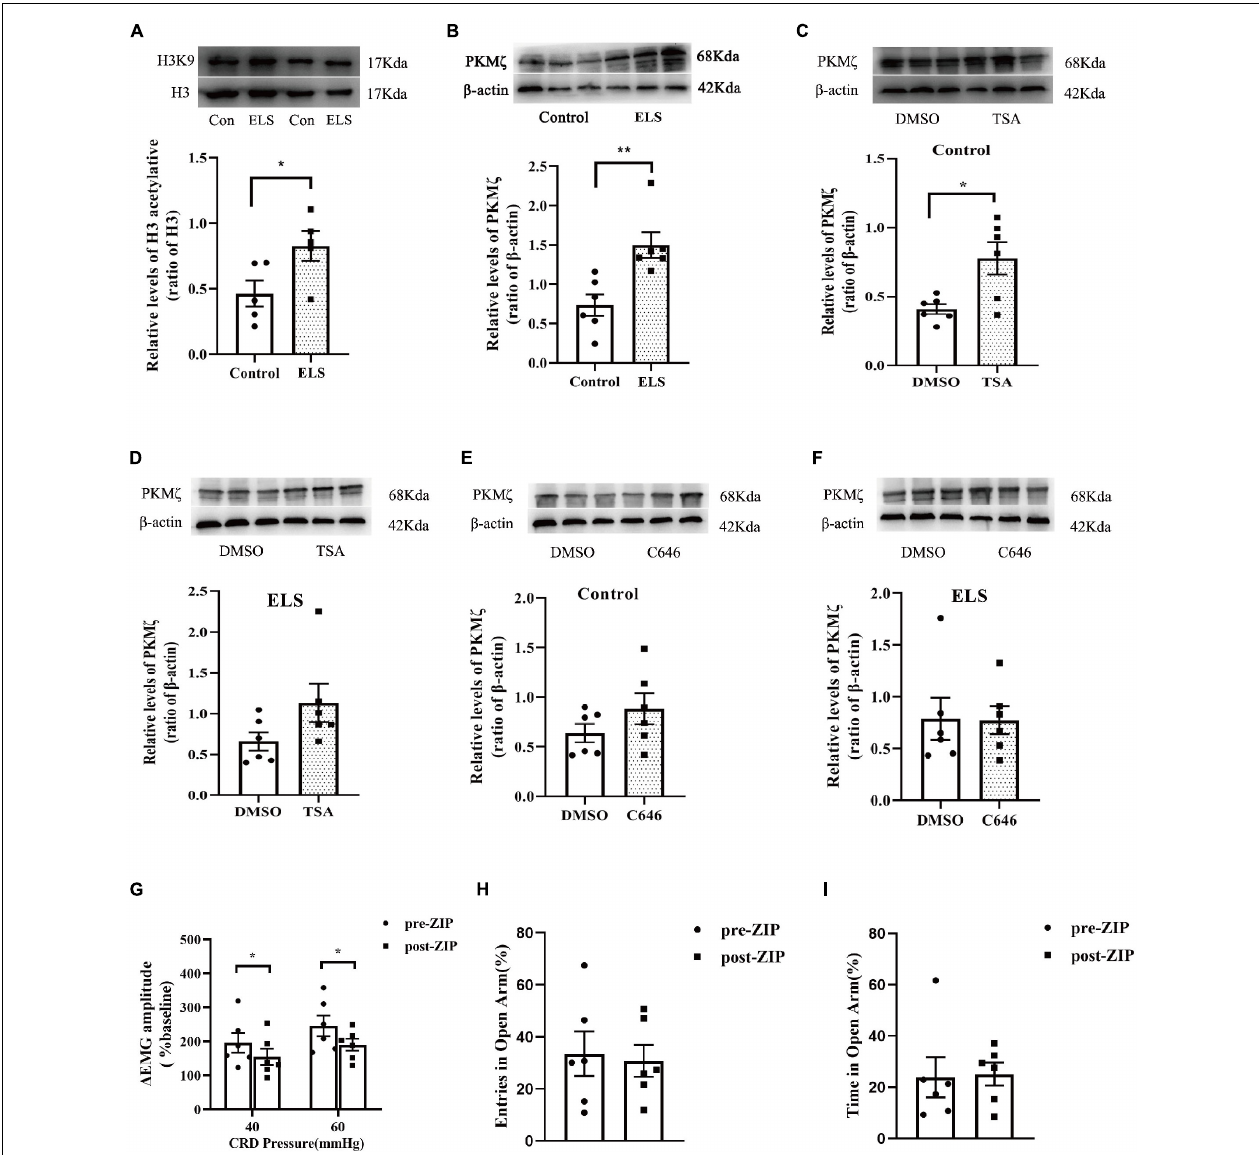
FIGURE 3 | The expression of acH3K9 and PKM ζ in the amygdala of rats. And effects of ZIP on visceral hypersensitivity and anxiety-like behaviors in rats. Western blot showed that the expression of AcH3 (A) and PKM ζ (B) increased in ELS rats compared to that in the controls. N = 5. (C,D) TSA treatment of CeA enhanced PKM ζ expression in the control rats (C) but not in the ELS rats (D) . (E,F) C646 treatment of CeA did not affect PKM ζ expression in both the control (E) and ELS rats (F) . ZIP (a PKM ζ inhibitor) treatment of CeA attenuated visceral hypersensitivity (G) without affecting entries (H) and time (I) in the open arms of the EPMT in ELS rats. * p < 0.05, ** p < 0.01. N = 6. Independent samples t -test was performed (A,C–F) . One-way ANOVA and Mann–Whitney U test were performed (B) . A paired-samples t -test and Wilcoxon signed-rank test were performed (G–I) . N represents the number of rats per